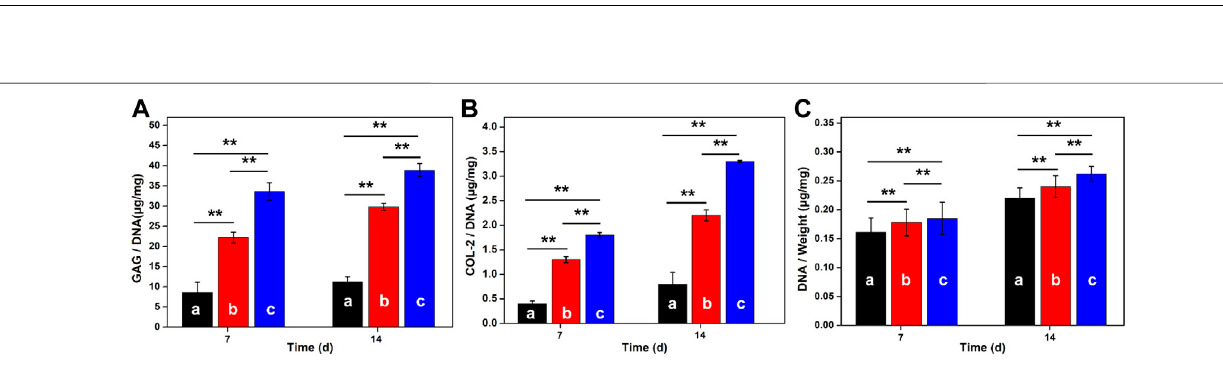
Frontiers in Pharmacology |